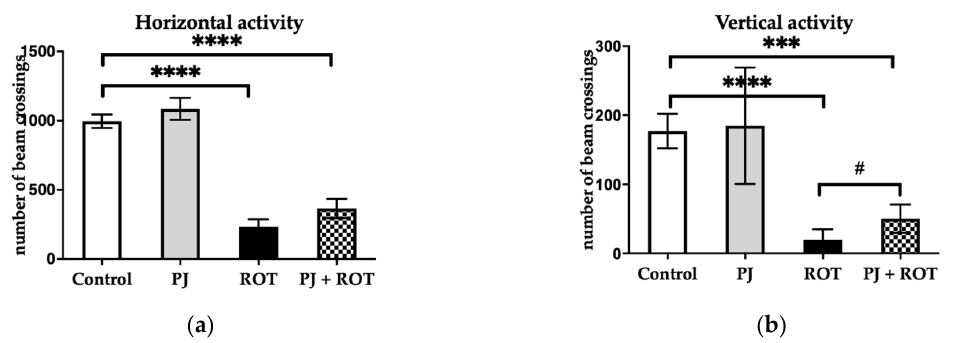
Figure 2. Effect of pomegranate juice treatment (PJ) on: ( a ) horizontal activity; ( b ) vertical activity in rotenone (ROT)-injected rats. Data are presented as mean values ± SEM of eight rats per group and analyzed using one-way analysis of variance (ANOVA) followed by Fisher’s LSD test. **** p < 0.0001 vs. Control; *** p < 0.001 vs. Control B; # p < 0.05 vs. ROT.